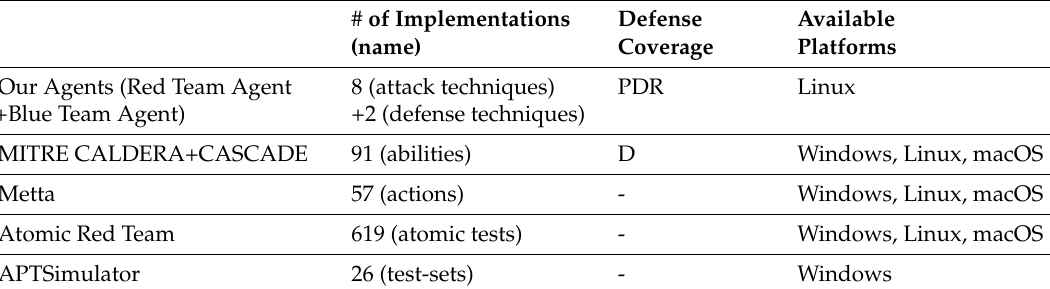
Table 4. Comparison among adversary emulation